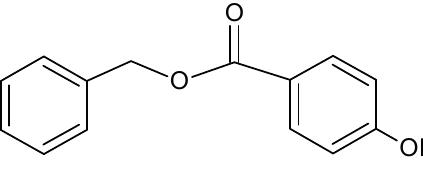
Figure 1. Benzylparaben